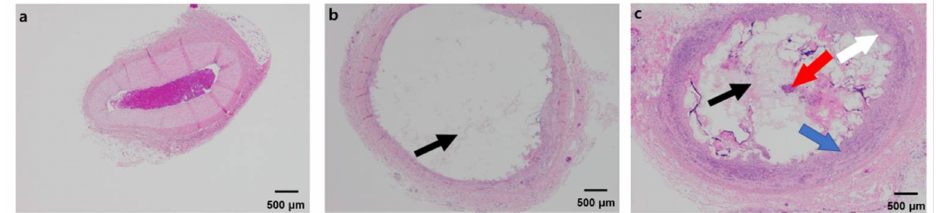
Figure 6. Histological images of EGpresto stained by H&E (X40). ( a ) normal veins (control), ( b , c ) two different spots from EGpresto-injected veins. In ( a ), a control epigastric vein image shows typical tissue layers and normal intima, media, and adventitia layers. Only a blood clot appeared in the endovascular area. This control epigastric vein sample was harvested from the same pig as in ( b , c ) but at an opposite side. In ( b , c ), the adhesive materials are indicated by black arrows. The red arrow in ( c ) indicates an inflammatory cell. Blue and white arrows indicate a fibrosis area and intima proliferation, respectively. However, the inflammatory cells are defined only in ( c ). These epigastric vein samples were harvested from a different injection site of the same epigastric vein.